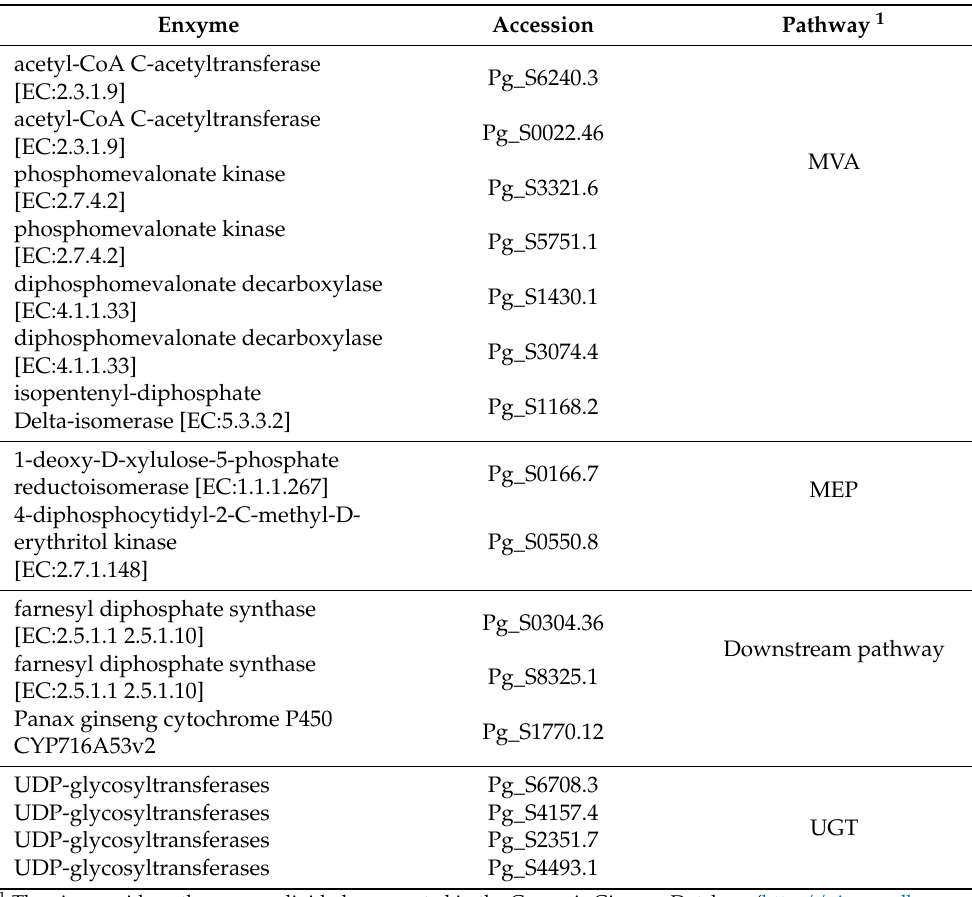
Table 1. Proteins identified in ginseng related to the ginsenoside biosynthesis pathway. Enxyme Accession Pathway 1